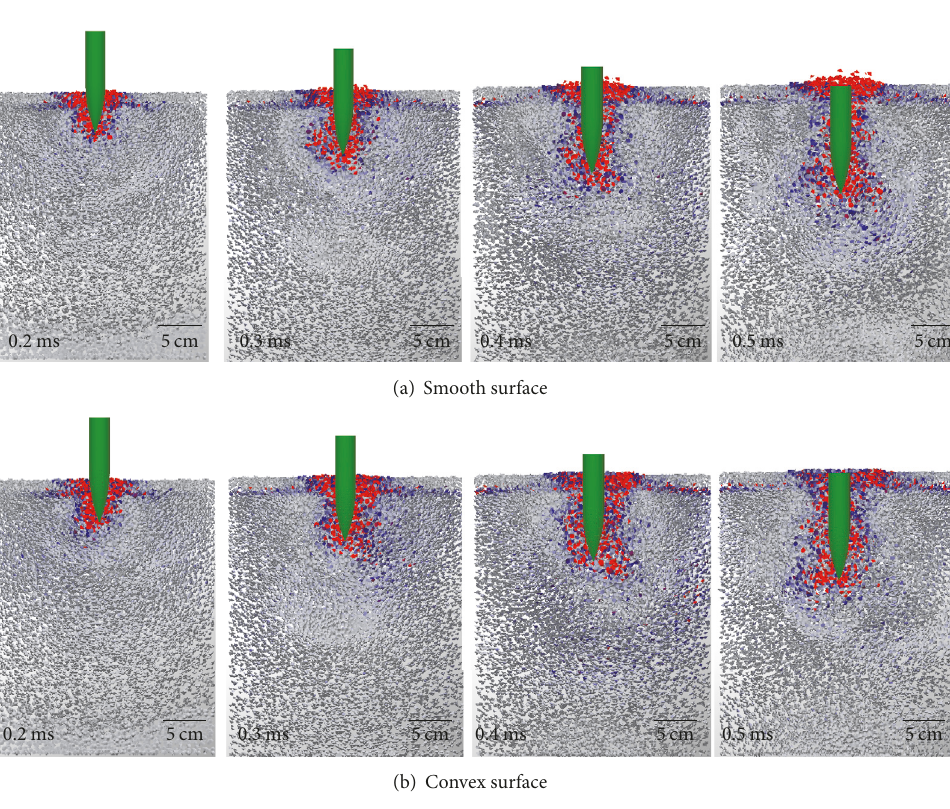
Figure 11: Kinetic energy distribution for the target particle: (a) smooth surface and (b) convex surface.